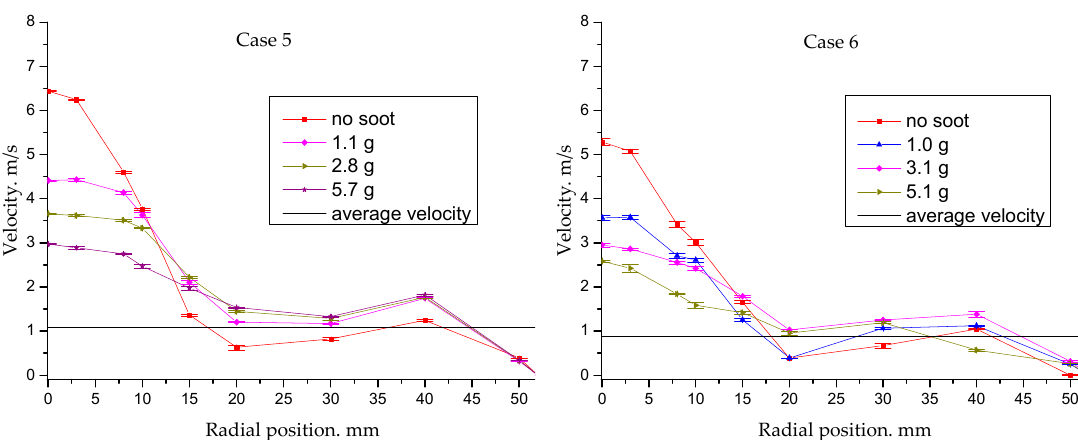
Figure 13. Velocity profiles of case 5 (conventional cone) and case 6 (NURBS cone); the average velocities are 1.09 m/s and 0.89 m/s, respectively.